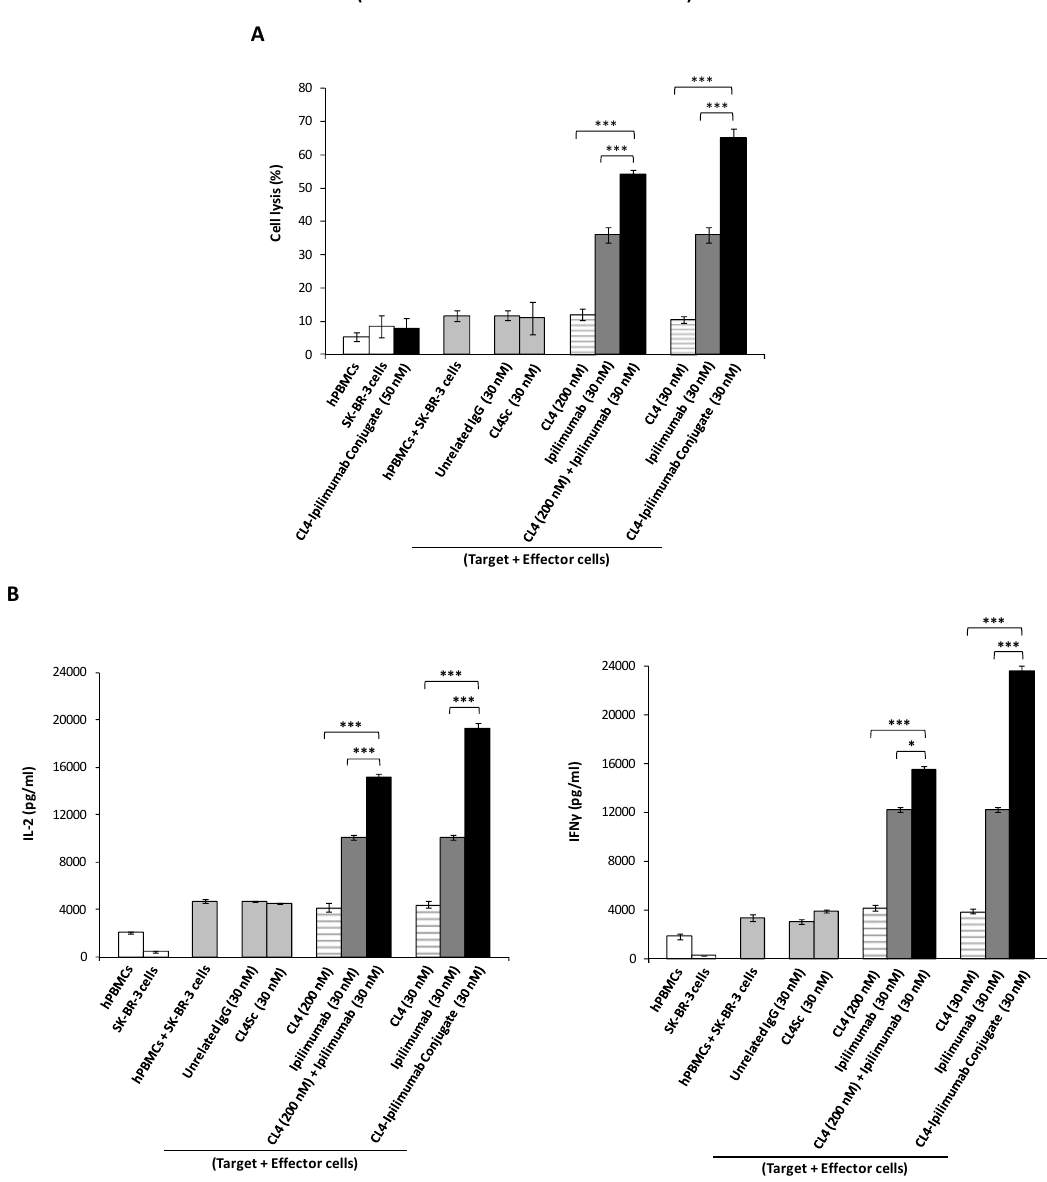
Figure 6. Cytotoxic effects of CL4-ipilimumab conjugate on SK-BR-3 tumor cells co-cultured with hPBMCs. ( A ) SK-BR-3 cells were co-cultured with hPBMCs (Effector:Target cells ratio 3:1) and treated for 24 hours with CL4 aptamer (striped bars), ipilimumab mAb (grey bars), their combination or CL4-ipilimumab conjugate (black bars) at the indicated concentrations SK-BR-3 cells separately treated with the immunoconjugate, the scrambled aptamer, or with hPBMCs were included as controls. Cell lysis was measured as described in Materials and Methods. ( B ) IL-2 and IFN- γ secretion levels were measured by ELISA on supernatants of cells treated, as indicated. Error bars depict means ± SD. p - values for the indicated treatments are: *** p ≤ 0.001; * p < 0.05.